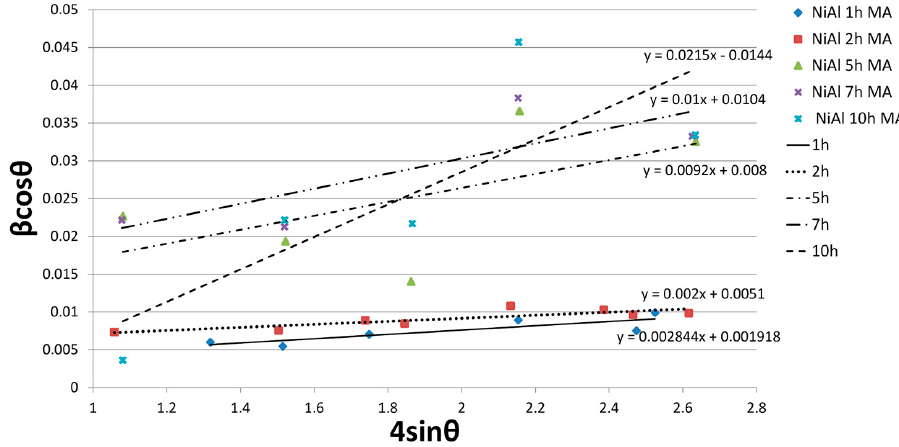
Figure 4. Linear Williamson–Hall plots with an obtained equation based on the XRD spectra of NiAl powder after various milling times.